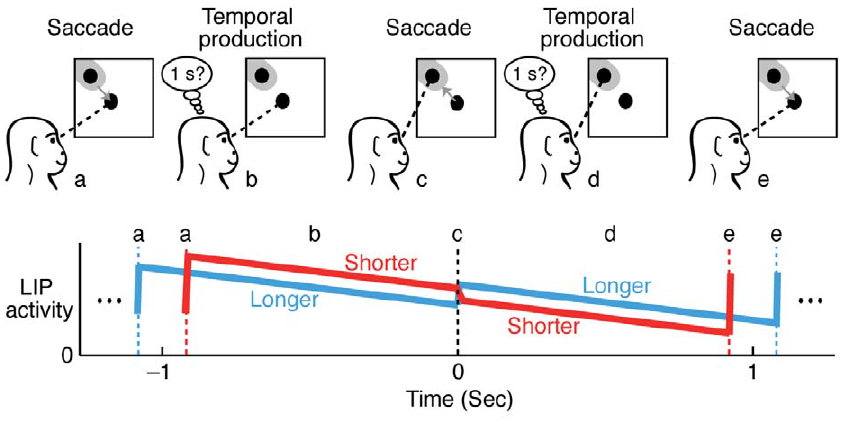
Figure 2. LIP activity during the temporal production task of Schneider and Ghose, 2012. Monkeys were trained to repetitively saccade (gray arrows) between a central and peripheral target at 1-s intervals. The monkeys were rewarded at a random time only if all the proceeding saccade intervals were within 200 ms of the 1,000 ms goal, and no sensory cue was provided to indicate the true interval duration. When the monkey made a saccade to the central target (a), LIP activity increased because the peripheral target was brought into the response field (gray region). While the animal waited to make a saccade back to the peripheral target (b), LIP activity slowly declined, but was greater for shorter saccade intervals (red trace) compared to longer intervals (blue trace). After the saccade to the peripheral target (c), the correlation between LIP activity and saccade interval reversed (d) until the next saccade to the central target (e). Interestingly, there was no pre-saccadic increase in LIP activity before the saccade to the peripheral target (c).